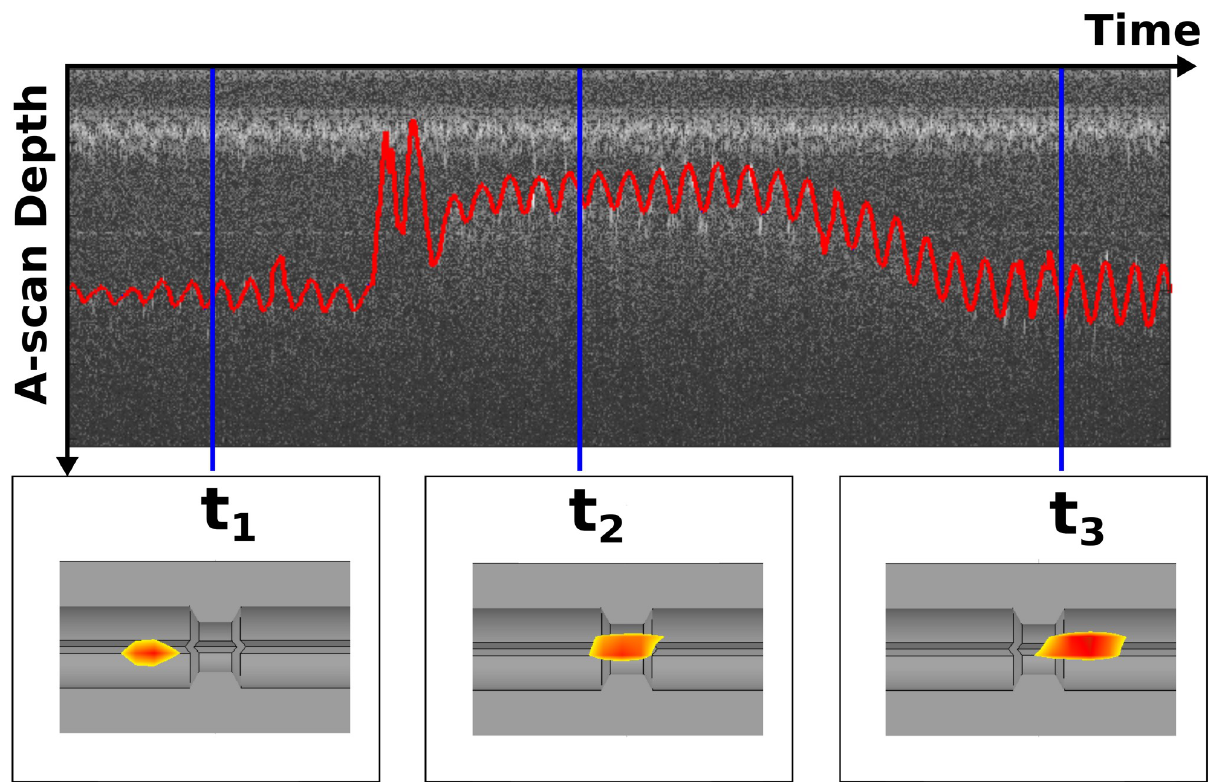
Fig 2. Exemplary IVOCT and MPI data. The OCT A-scans are arranged over time (top). The segmented phantom boundary is highlighted in red. For three time stamps t i , the related MPI signals from catheter tip are shown within the CAD sketch (bottom).